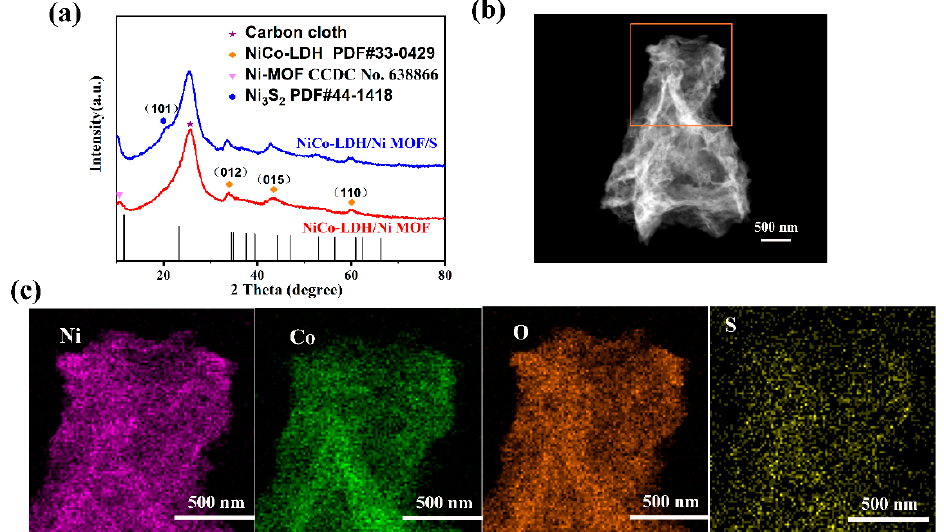
Figure 3. ( a ) XRD patterns of NiCo LDH/Ni MOF and NiCo LDH/S-Ni MOF ( b , c ) EDS mapping of NiCo LDH/S-Ni MOF samples.